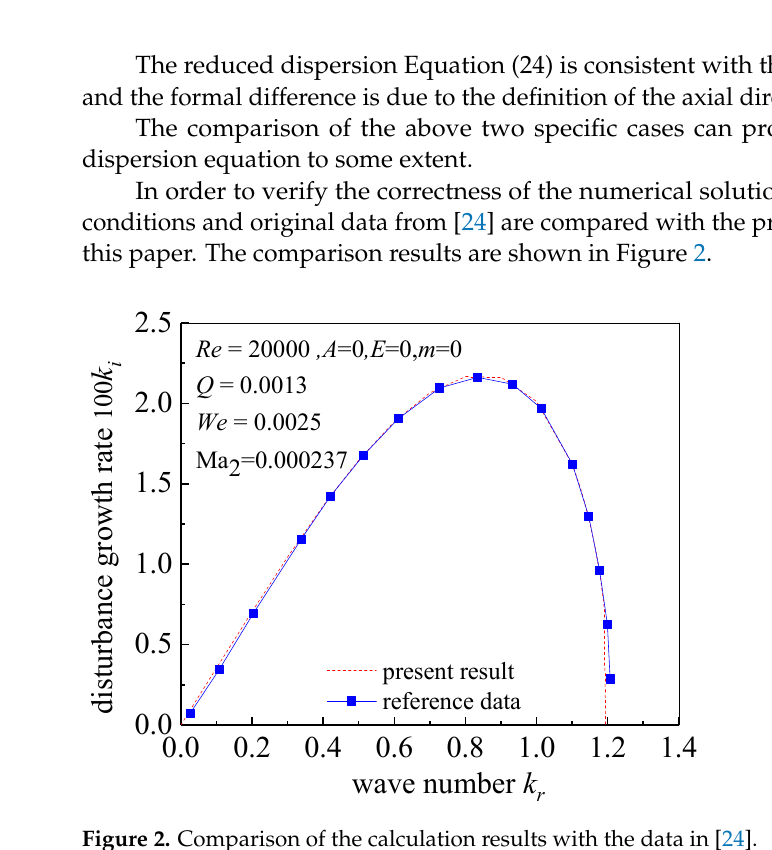
Figure 2. Comparison of the calculation results with the data in [24].